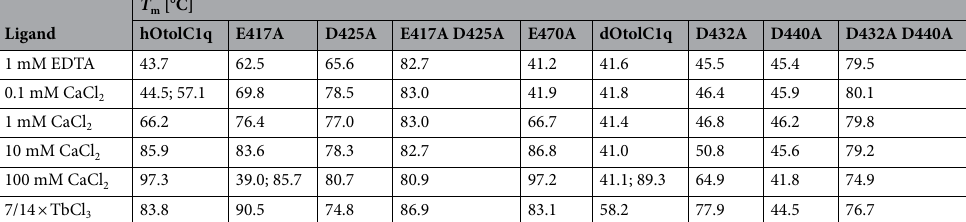
Secondary structure changed by the addition of Ca 2+ ?